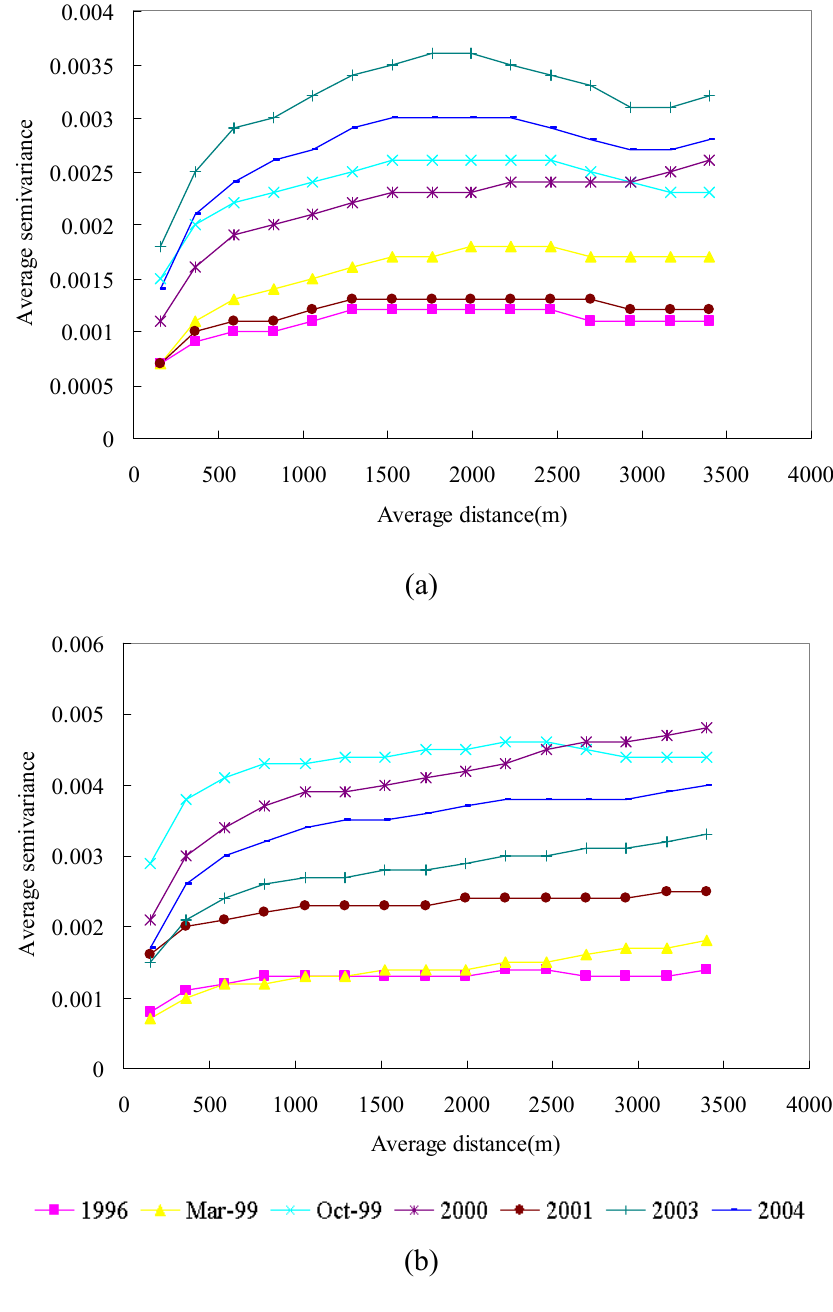
Figure 4. Experimental variograms of NDVI images before and after disturbances in areas (a) A and (b)